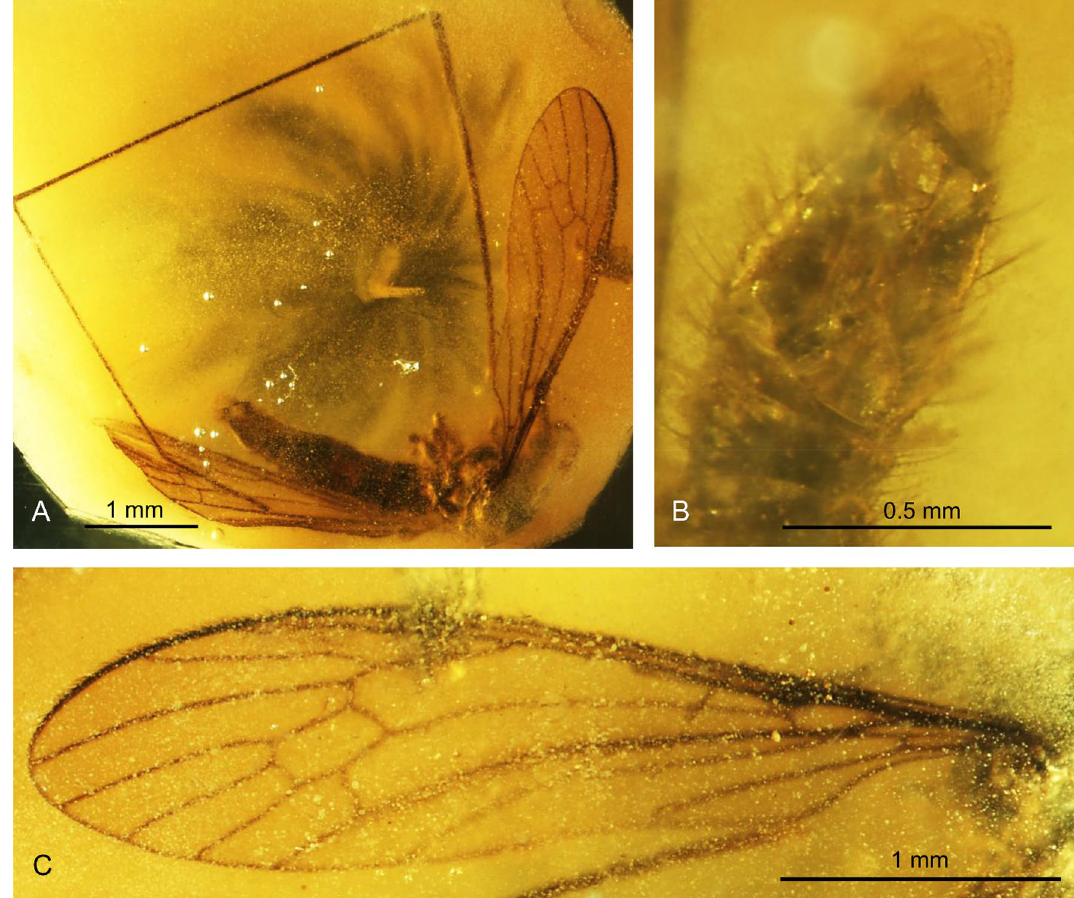
Figure 2. Helius turolensis sp. nov. No. 53–10-54 (male), holotype. ( A ) body, latero-ventral view; ( B ) hypopygium; ( C ) Helius turolensis sp. nov.. (Figs. 1, 2).